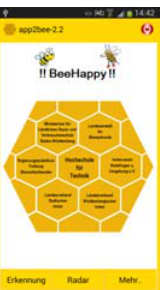
Figure 11: Main Menu. The user selects Flower recognition (“Erkennung”), shows honey yield geo-information (“Radar”) or uses additional functions (“Mehr”) (Source: Shohrab Uddin).